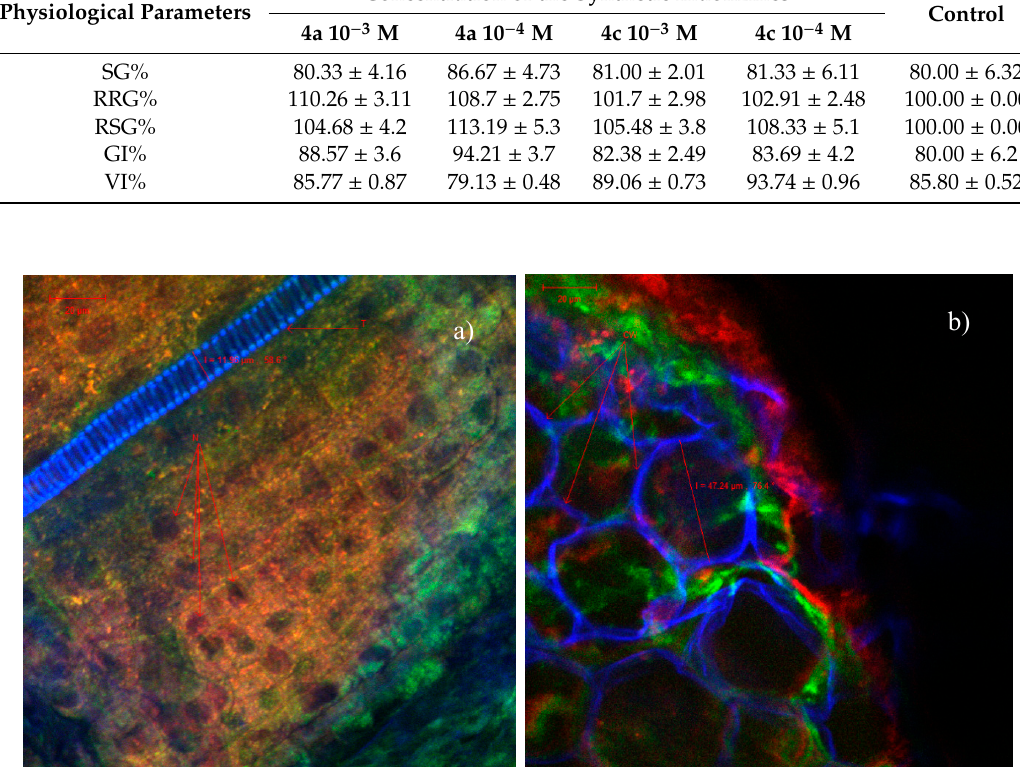
Figure 8. CLSM images of the wheat sprout sections of the indolizine 4a treated samples at two different concentrations: ( a ) 10 − 3 M, ( b ) 10 − 4 M.